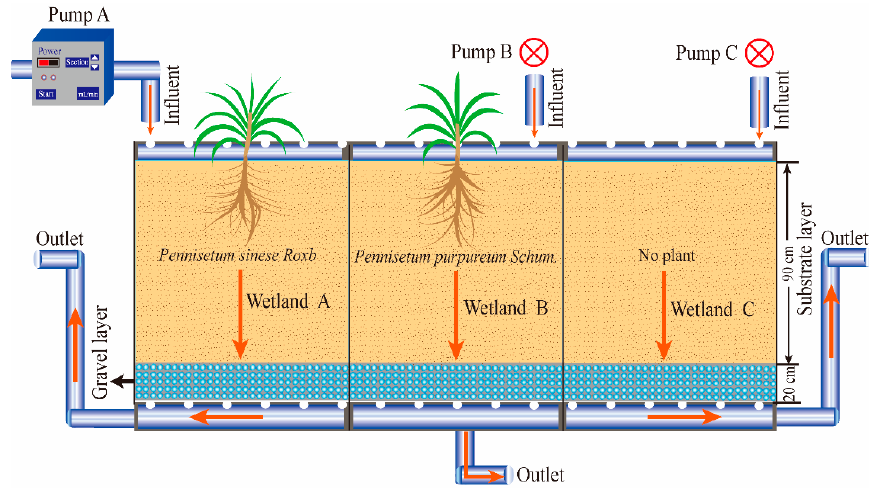
Figure 1. Schematic diagram of profile and plan of vertical flow constructed wetlands (VFCWs).